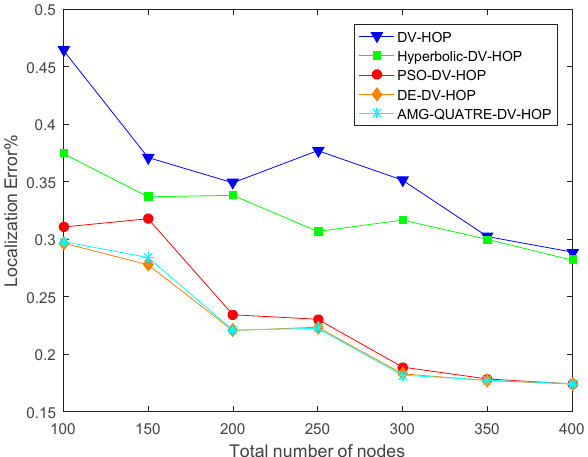
Figure 11. Comparison of average localization error of the applied AMG-QUATRE with the other methods for the different number of sensor nodes. Table 8. Comparison of the applied AMG-QUATRE with the other methods by different sensor nodes. Sensor Nodes